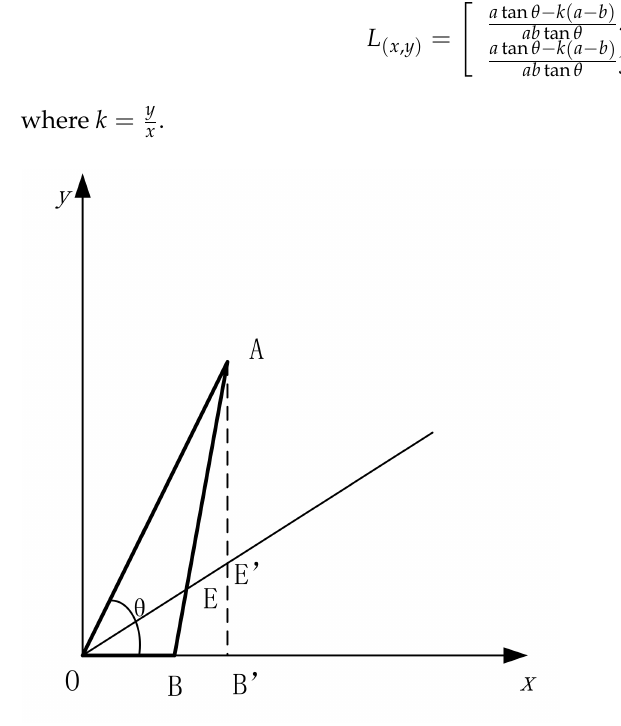
Figure 1. Mapping of the segmented irregular triangular